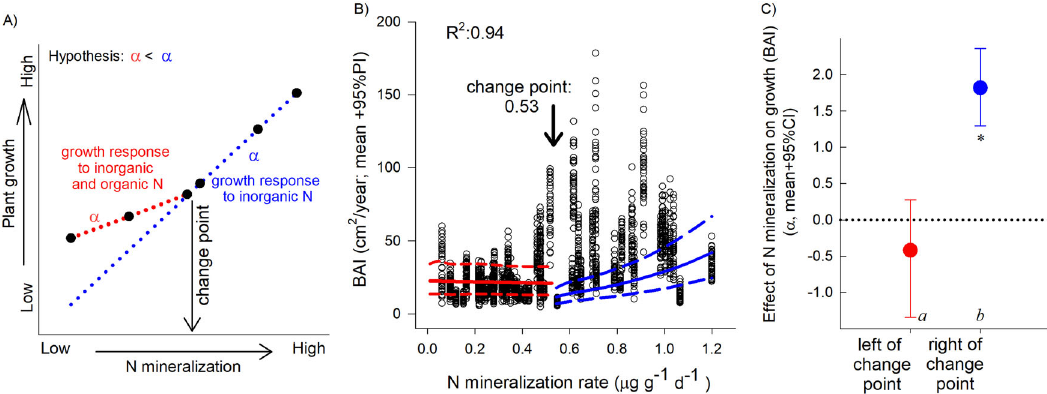
Fig. 2 Analysis framework and modeled contribution of inorganic N and N-SOM to plant growth. A Representative analysis of tree growth as a function of net N mineralization rates. The change point analysis identi fi es the occurrence and location of an in fl ection point, if any, and the value of the slope parameters on each side. B Basal Area Increment (BAI), from 54 Q. rubra trees along the studied net N mineralization gradient (black circles correspond to an individual growth year). Red and blue lines indicate model estimated BAI mean and 95% PI above and below the identi fi ed change-point (BAI change point; estimates were calculated at average values of the other covariates). R 2 denotes overall Bayesian model fi t. C Slope parameters are signi fi cantly different from each other (95% CIs do not overlap; different letters ( n = 54). Asterisks indicates parameter is different from zero (95% CI does not overlap with